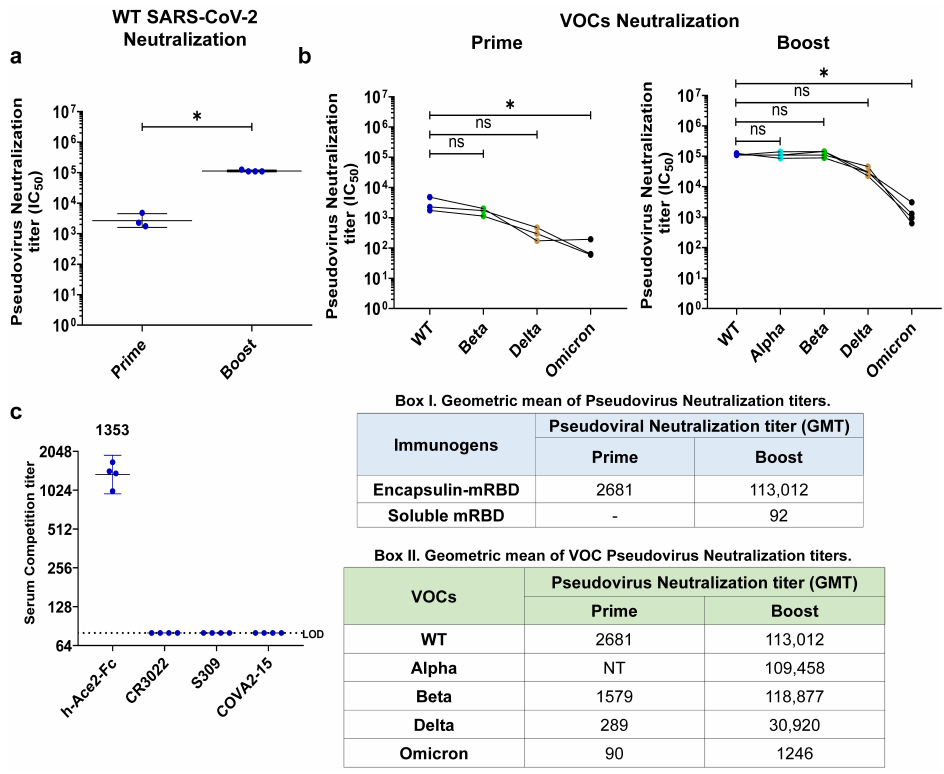
Figure 4. Neutralizing antibody response induced by encapsulin–mRBD nanoparticles in mice. ( a ), Pseudoviral neutralization titer (IC 50 ) in sera elicited by encapsulin–mRBD nanoparticles mea- sured two weeks after prime and boost immunizations. Neutralizing antibody titers between groups were compared using two-tailed Mann–Whitney tests (* indicates p < 0.05 and ns indicates not significant). ( b ), Pseudovirus neutralization titers elicited by encapsulin–mRBD nanoparticles against variants of concern (VOCs) evaluated two weeks after prime and boost immunizations. Statistical significance of differences between pseudovirus neutralization titers for different VOCs were ana- lyzed through Kruskal–Wallis test using Dunn’s correction (* indicates p < 0.05 and ns indicates not significant). IC 50 is defined as the sera dilution at which 50% neutralizing activity was observed. Geometric means of pseudovirus neutralization titers measured after prime and boost immunizations are indicated in Box I. Geometric mean of VOC pseudovirus neutralization titers measured after prime and boost immunizations are indicated in box II. NT indicates not tested. ( c ), ELISA titers (ID 50 ) of serum antibodies competing with mAbs—ACE2-hFc, CR3022, S309 and COVA2-15 for binding to overlapping epitopes on the vaccine antigen, mRBD. ID 50 is defined as the sera dilution at which 50% competition was observed. LOD is limit of